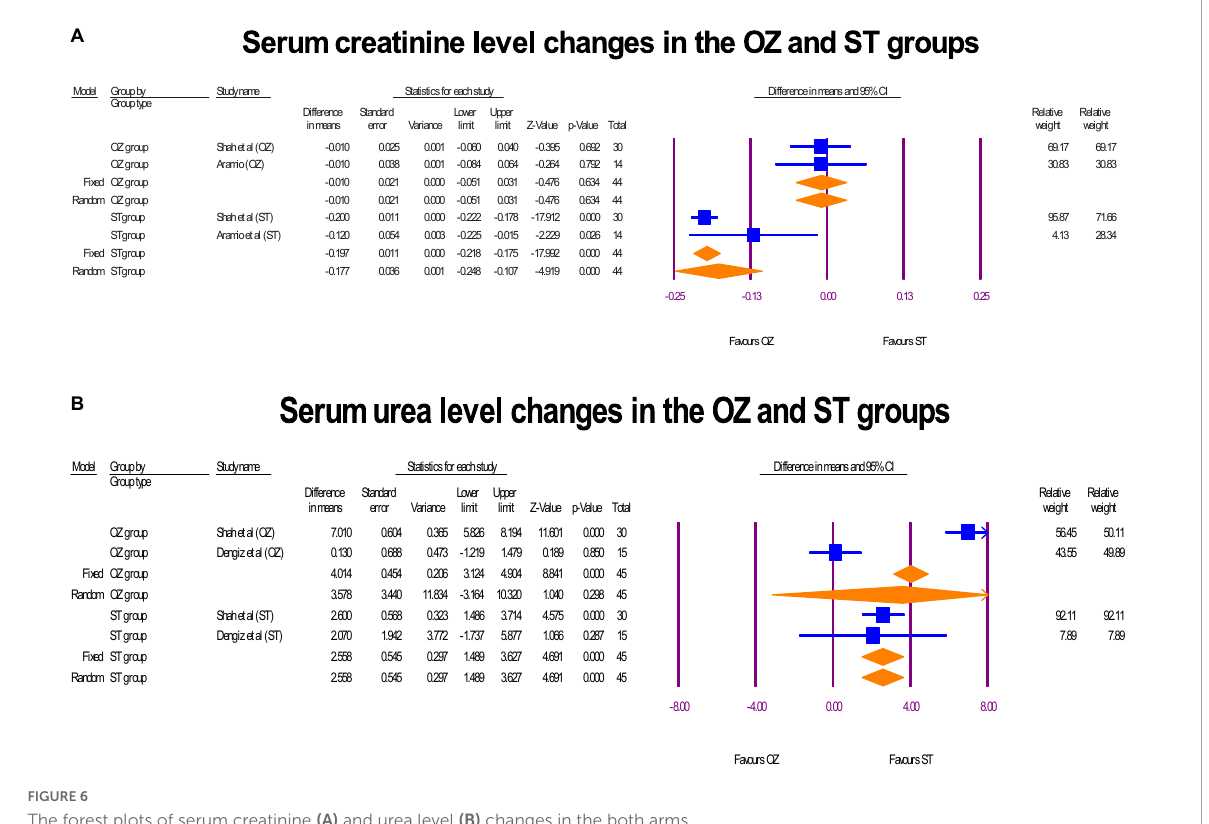
FIGURE6 The forest plots of serum creatinine (A) and urea level (B) changes in the both arms.